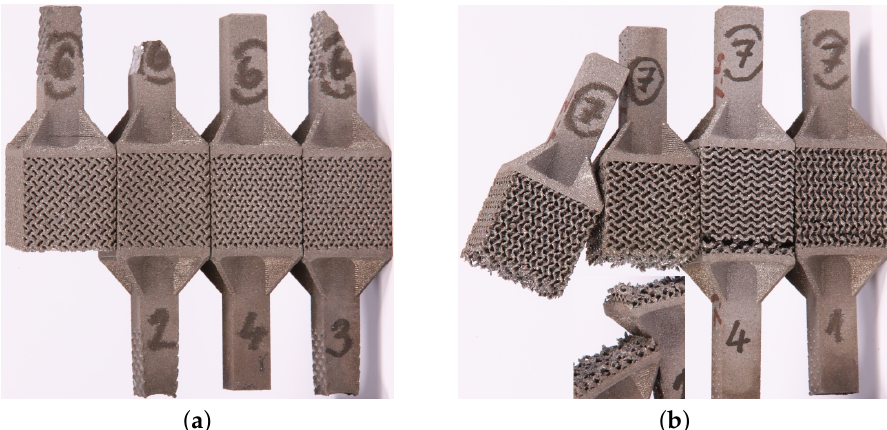
Figure 9. Fractured specimens undergoing tension: ( a ) failure at gripping section (samples 2, 3—porous structure corresponds to GII-2), ( b ) location of fracture surfaces near top base (porous structure corresponds to GII-3, specimens are positioned upside-down from the printing direction point of view).